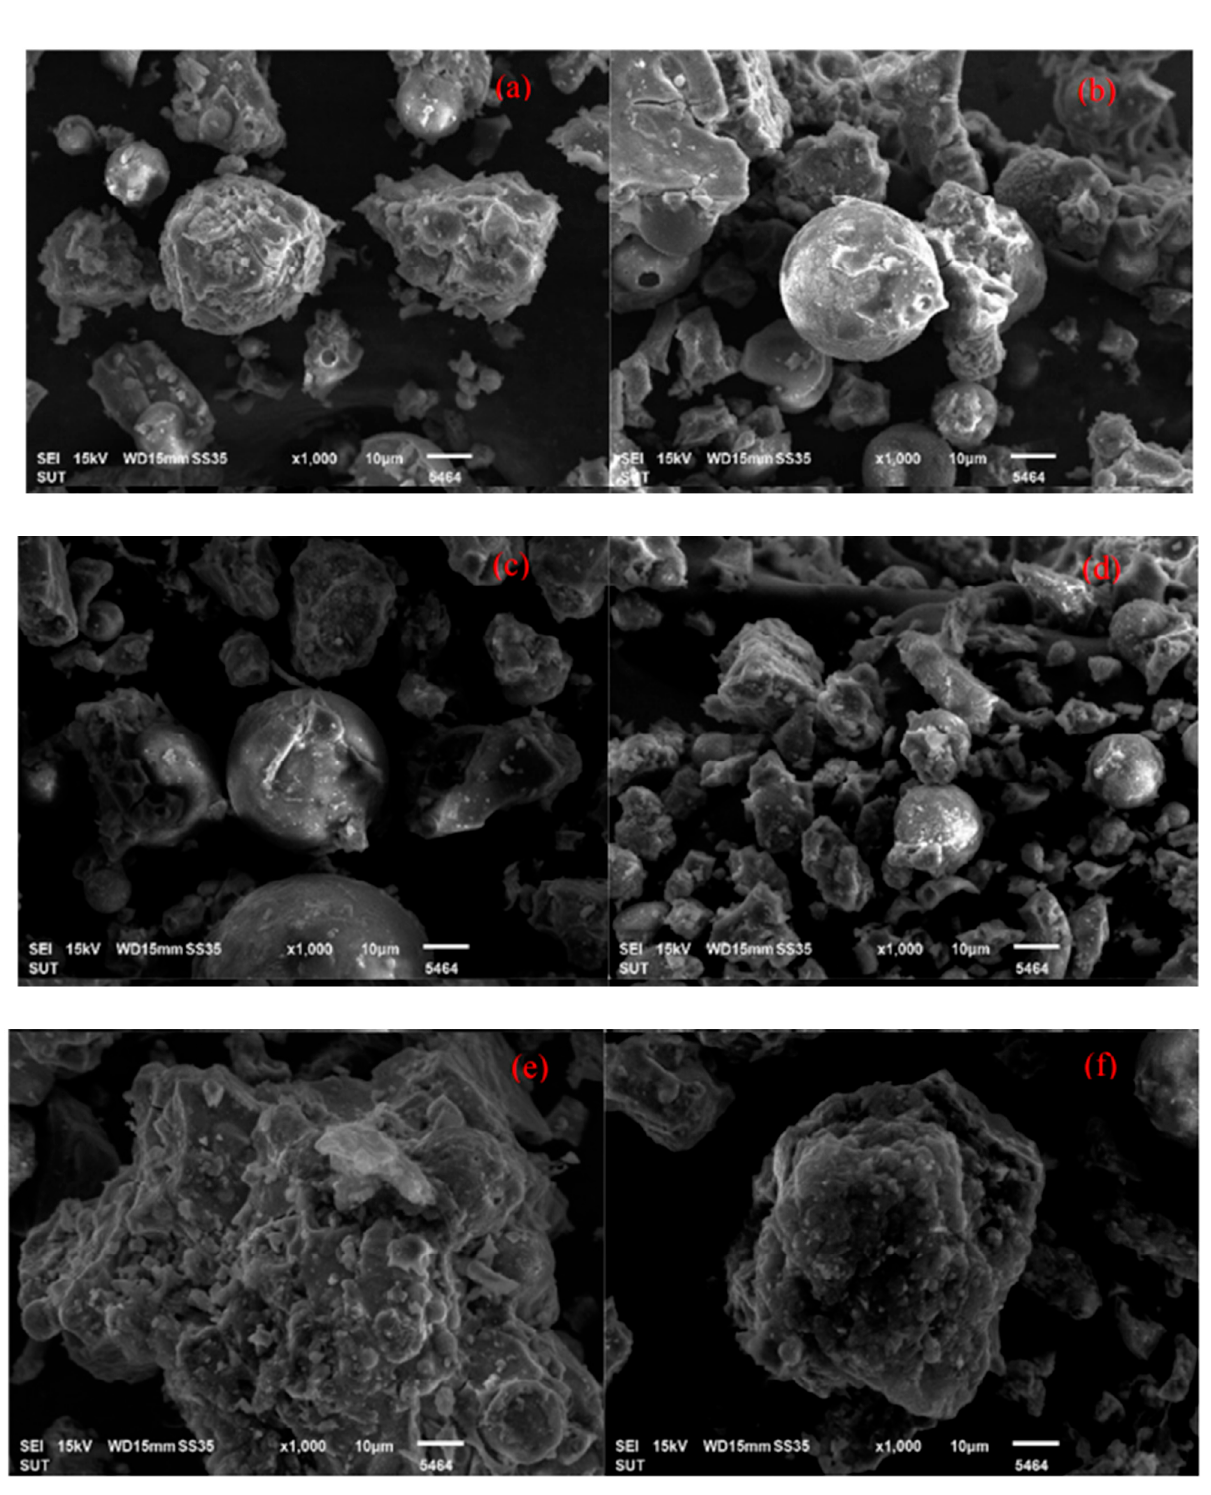
Figure 21. SEM images of a fracture surface of geopolymer nano-composite reinforced with carbon nanotubes ( a ) NaOH 10M control without MWCNTs ( b ) 10M control with CNTs 1 wt% ( c ) NaOH 15M control without MWCNTs ( d ) 15M control with MWCNTs 1 wt% ( e ) NaOH 20Mcontrol without MWCNTs and ( f ) 20M control with MWCNTs 1 wt%. [88].